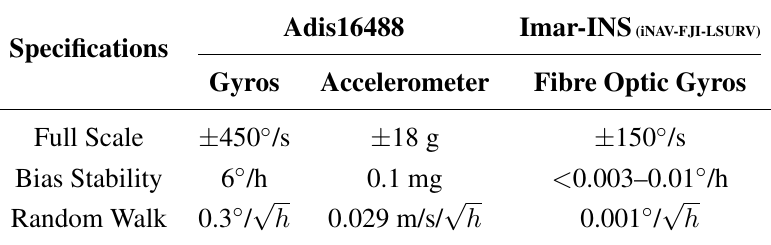
Table 1. Specifications of the